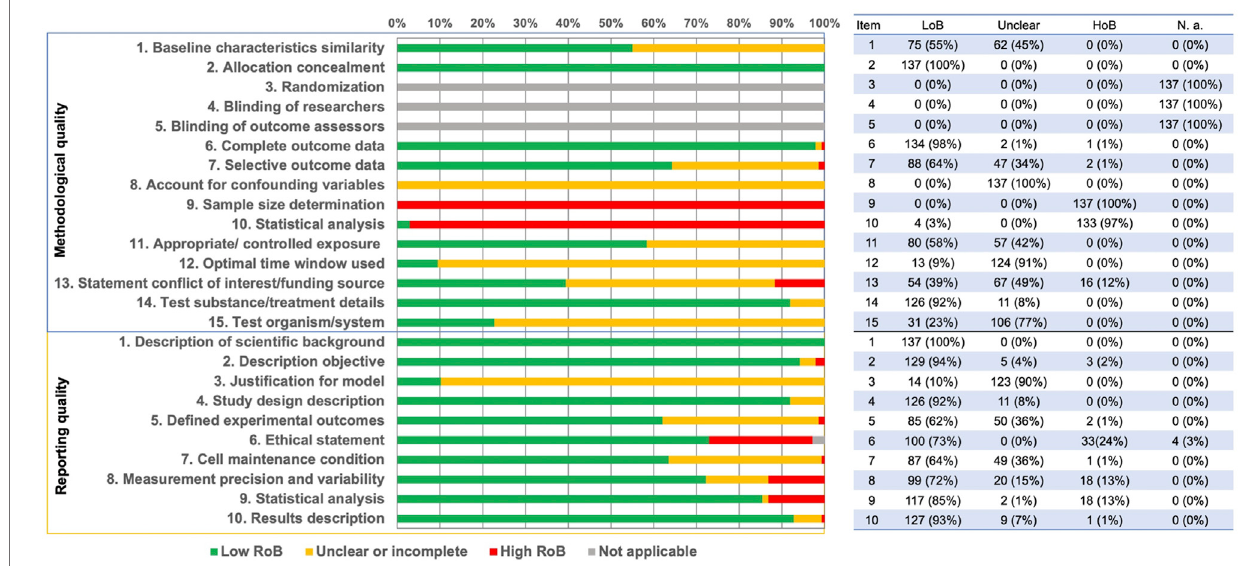
TABLE 2 | Summary statistics according to tension type and apparatus. Since some publications applied two tension types, the total number given here is larger ( n (cid:1) 140) than the number of studies identi fi ed ( n (cid:1) 137). Tension type (n) Tension applied with ( n )